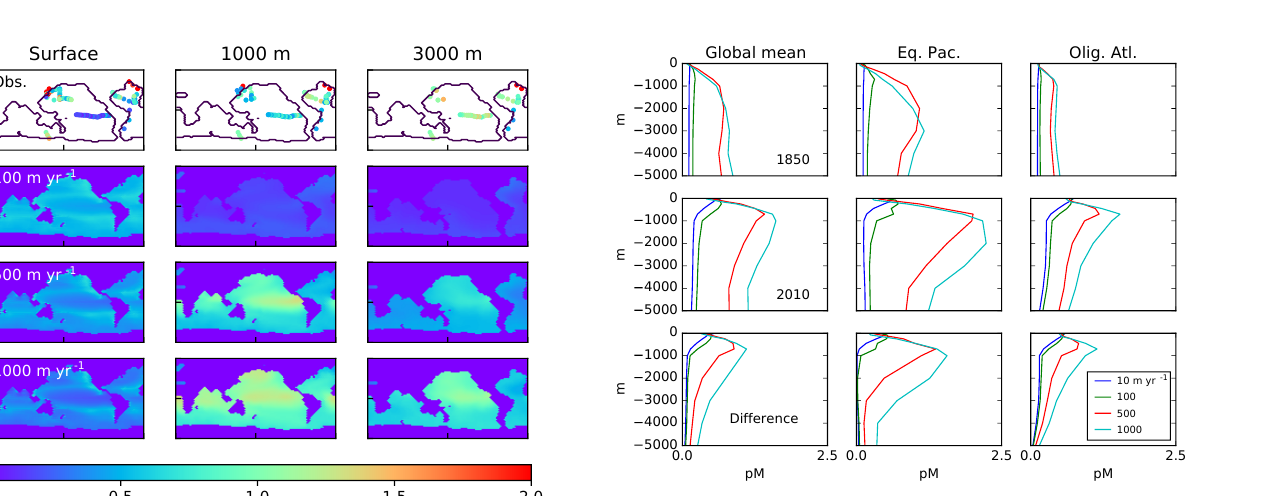
Figure 3. Depth profiles (in meters) of the total Hg concentration in the model: global mean and from locations shown in Fig. 4, showing preanthropogenic (1850), present-day (2010), and the difference be- tween the two, for different values of the particulate-bound Hg flux in meters per year (myr − 1 ; the base case is 500myr − 1